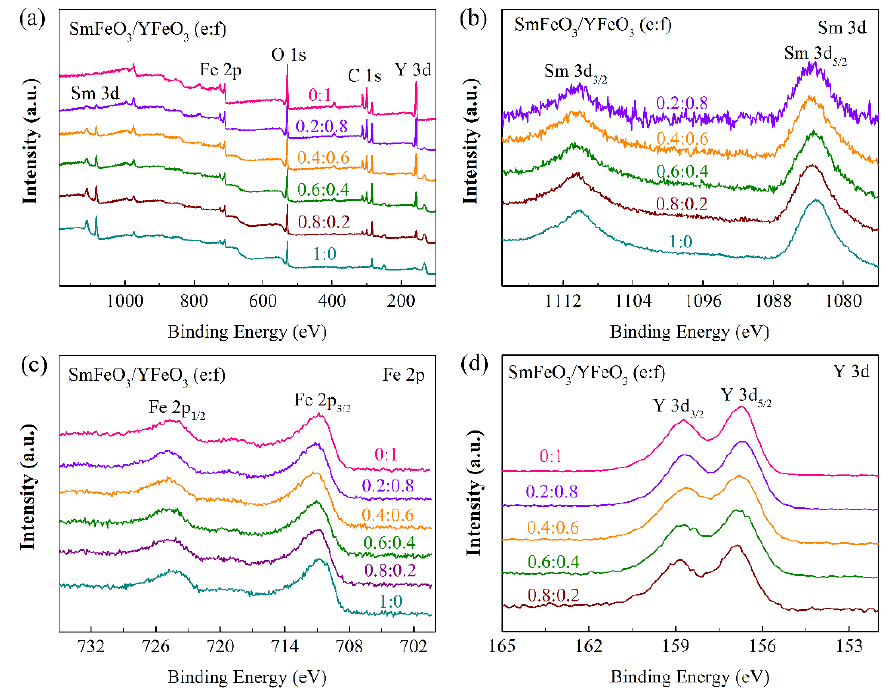
Figure 3. The XPS characterization of SmFeO 3 /YFeO 3 (e:f) nanomaterials: ( a ) overall spectra, ( b ) Sm 3d, ( c ) Fe 2p, and ( d ) Y 3d. 3d, ( c ) Fe 2p, and ( d ) Y